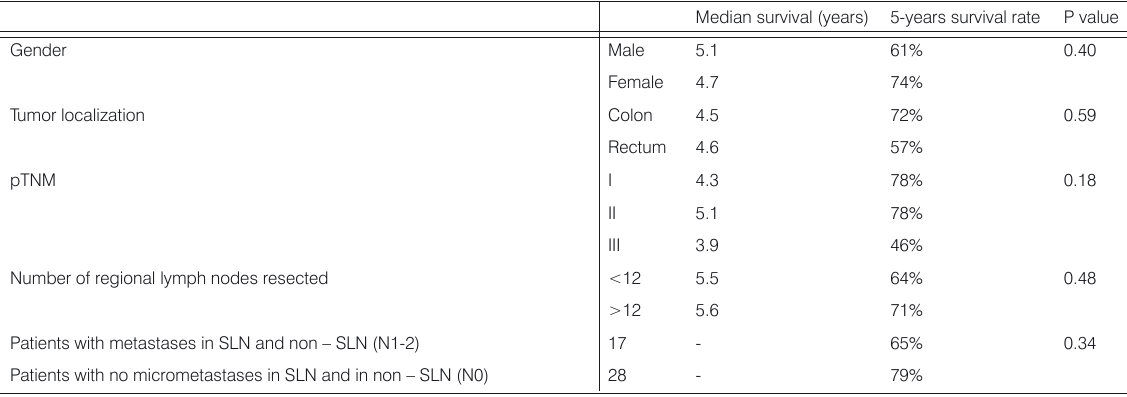
Table 2. Median survival and 5-years survival rates for colorectal cancer (CRC) patients undergoing surgery in Gdansk